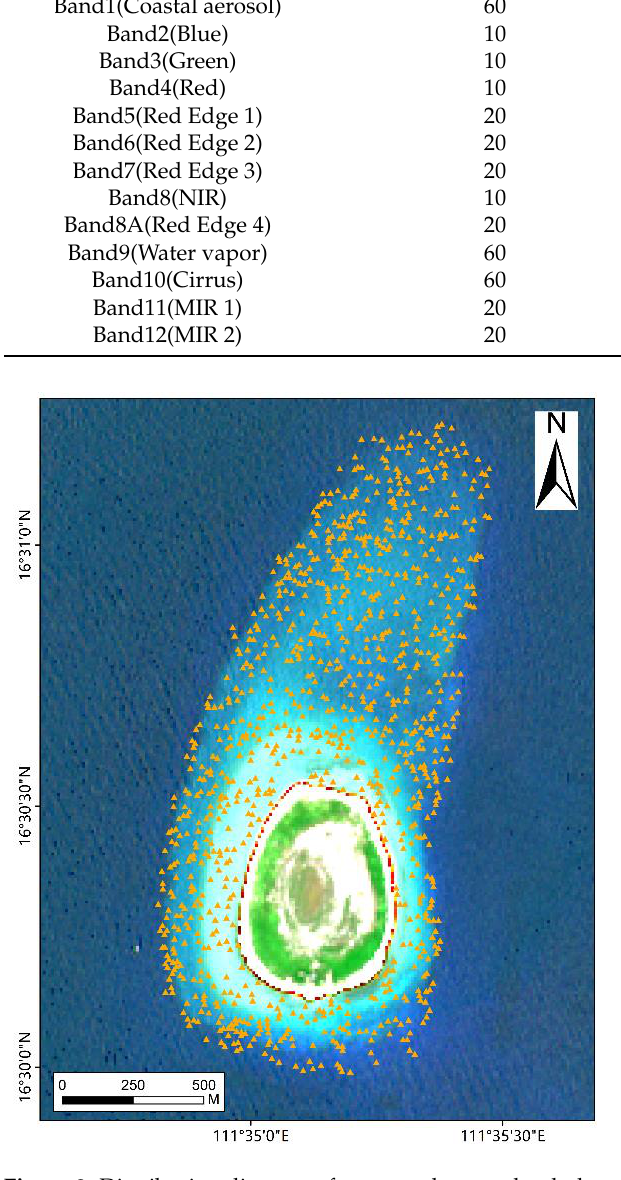
Figure 2. Distribution diagram of measured water depth data.